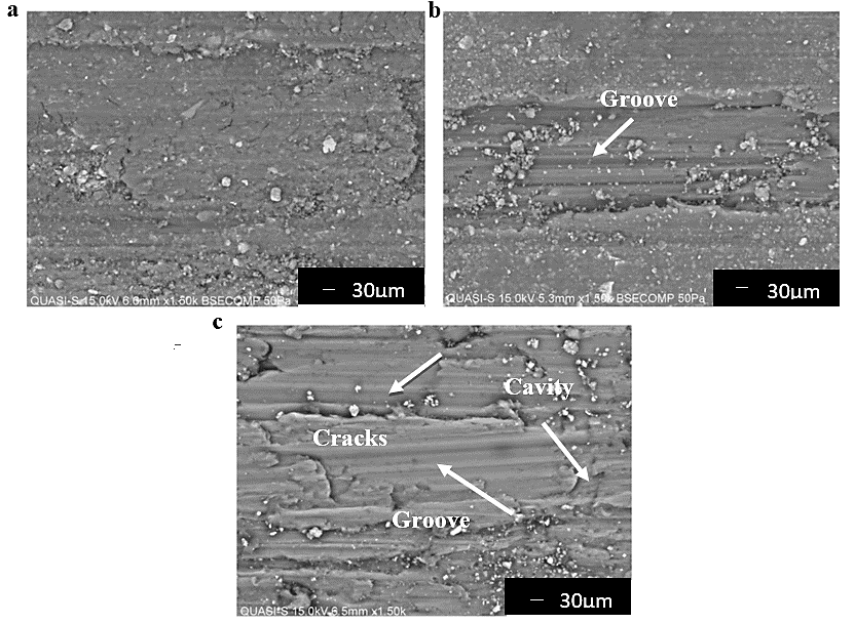
Figure 10. SEM image of LPCS Al coatings at an applied load of ( a ) 2 N; ( b ) 3 N; and ( c ) 5 N.